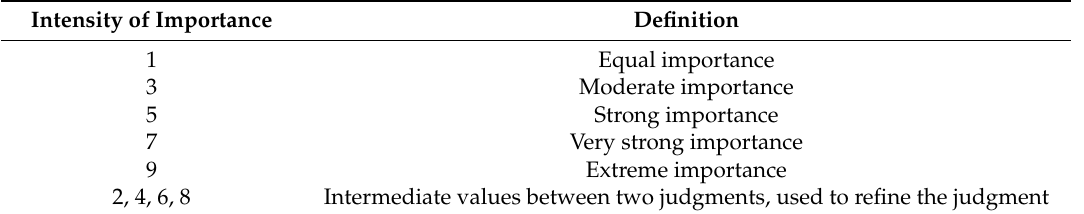
Table 3. Scale for pairwise comparison of Saaty.